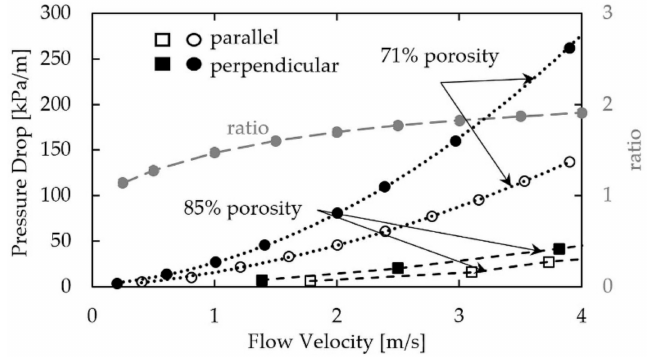
Figure 15. Pressure drop of two different aluminum short-fiber structures with fluid flow parallel and perpendicular to the isotropic plane.